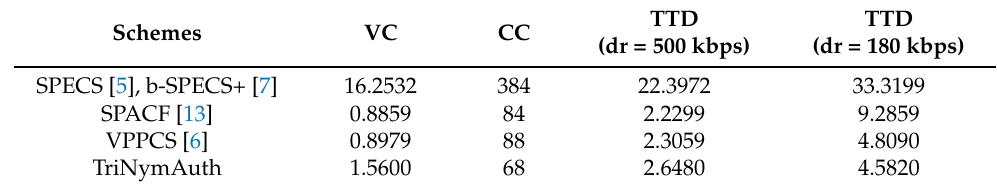
Table 6. Comparison of verification cost, communication cost, and total transmission